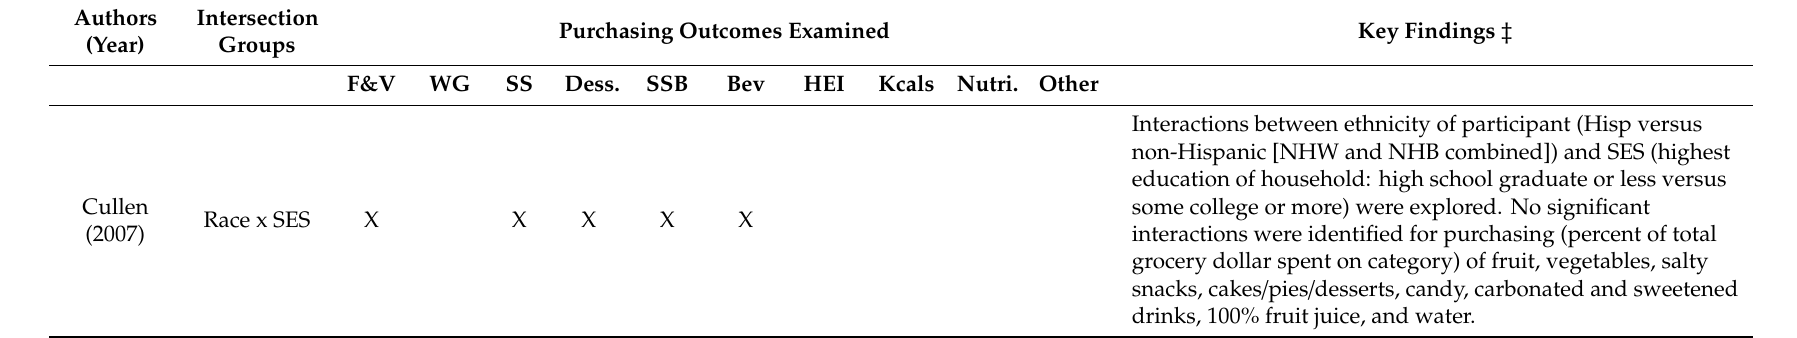
Table 3. Key Findings from Intersectional Studies ( n =